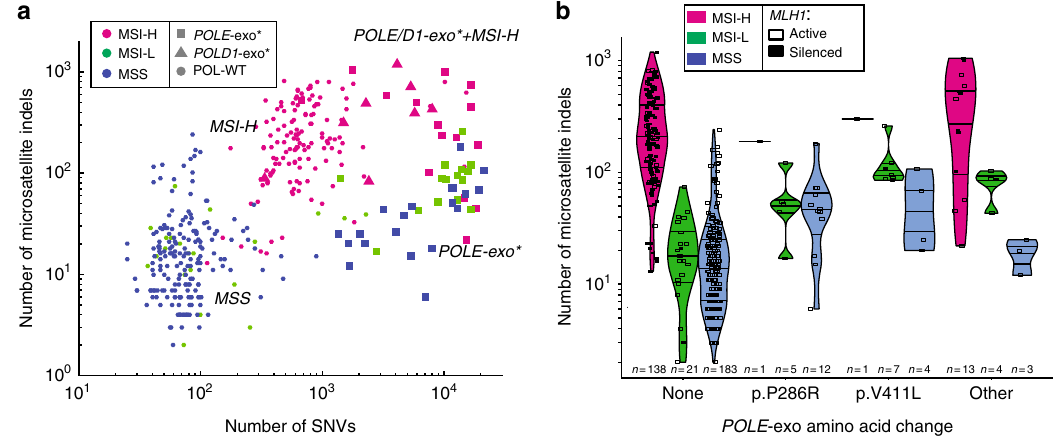
Fig. 1 The landscape of single-nucleotide variants (SNVs) and microsatellite indels in endometrial cancer. a Number of SNVs and microsatellite indels for tumors in the TCGA endometrial cohort (UCEC). Colors represent the TCGA microsatellite classi fi cation determined using the Bethesda protocol, 11 and shapes represent the mutation status of POLE and POLD1 exonuclease domains. All samples with available Bethesda classi fi cation and MS indel calls are shown ( n = 401). b Number of microsatellite indels for endometrial tumors with different POLE -exo* mutations. Color represents MSI status, and tumors with MLH1 epigenetic silencing are displayed as fi lled boxes. P286R and V411L are the two most common POLE exonuclease domain mutations in the cohort. All samples with Bethesda classi fi cation, MS indel calls, and MLH1 silencing calls available are shown ( n =